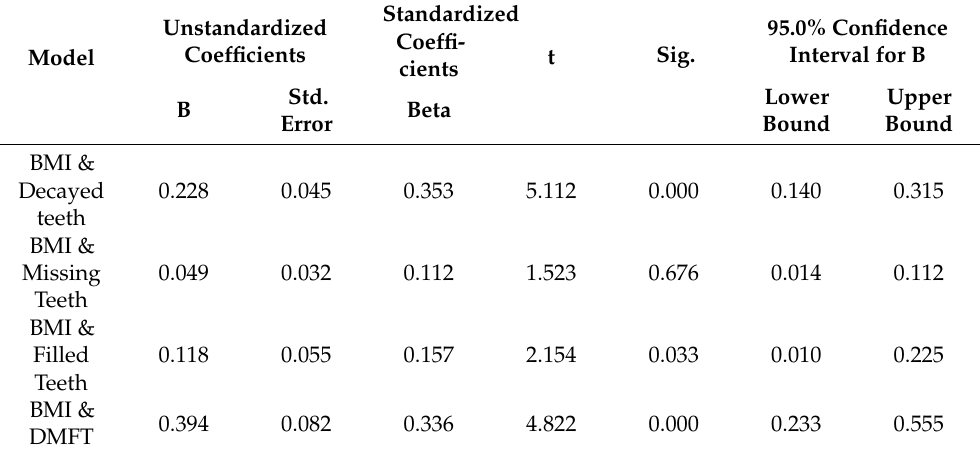
Table 4. Association of BMI with number of decayed teeth, missing teeth, filled teeth, and DMFT